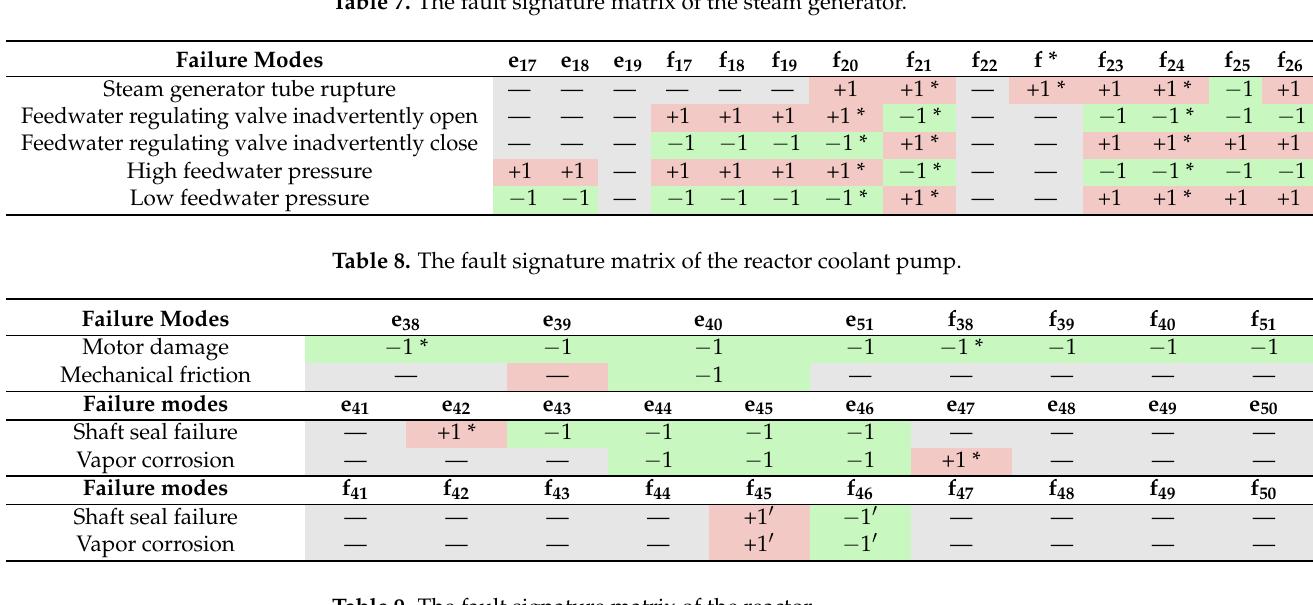
Table 9. The fault signature matrix of the